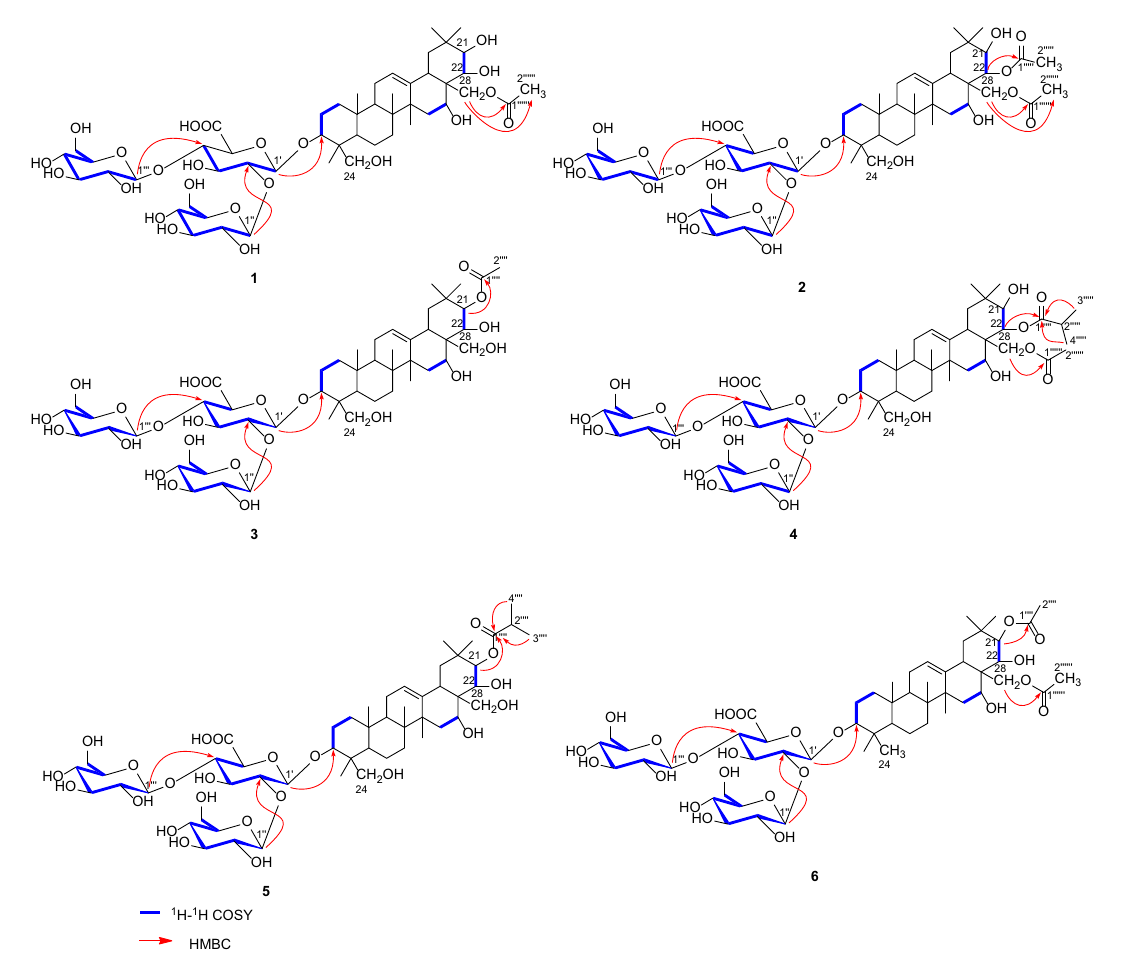
Fig. 2 Key COSY and HMBC correlations of compounds 1 –